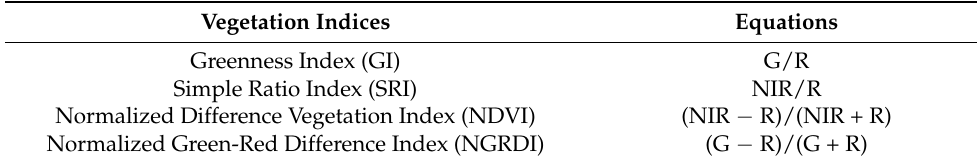
Table 1. The calculation formula of common vegetation indices. Vegetation Indices Equations